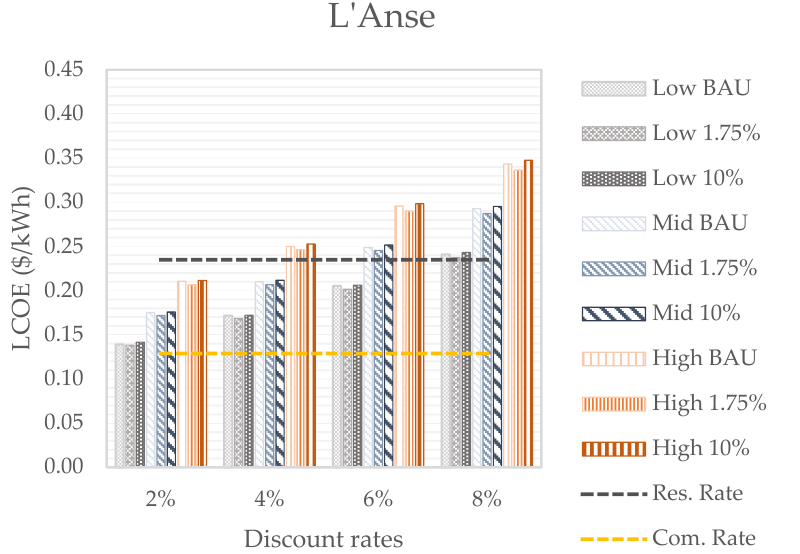
Figure 9. The sensitivity results for L’Anse with 45° tilt angle, different discount rate, varying components costs, and varying average load with and without energy efficiency considerations.